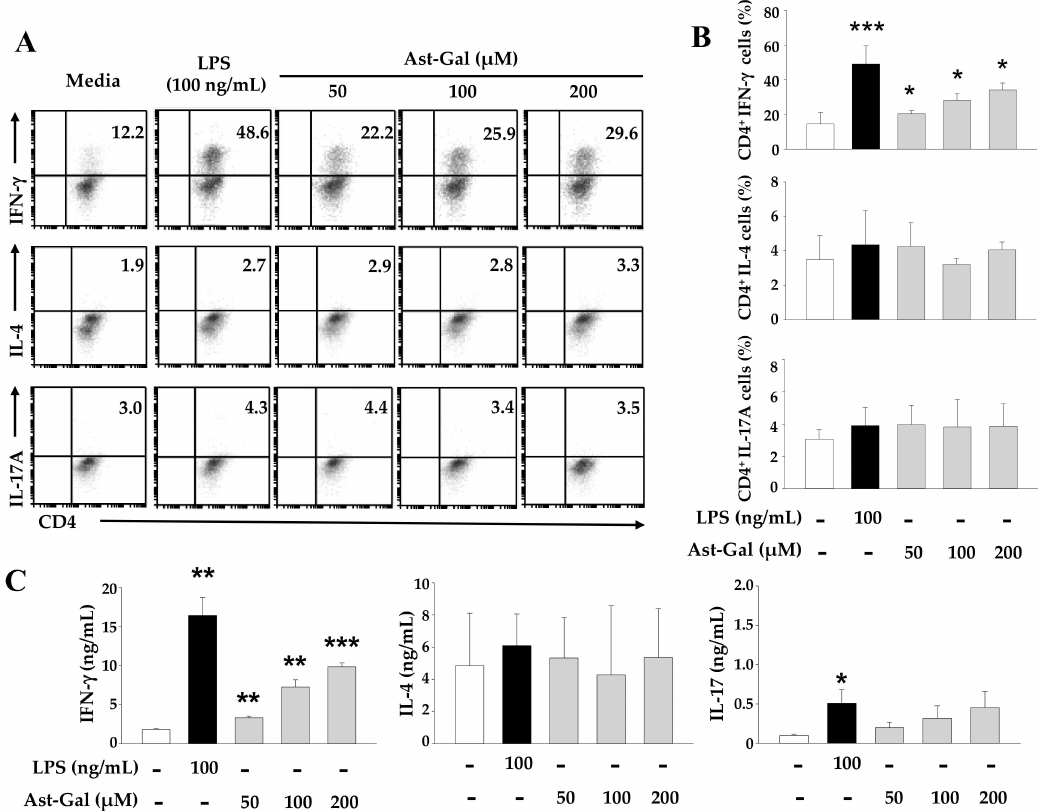
Figure 3. Ast-Gal-stimulated DCs increase IFN- γ production in CD4 + T cells in vitro. The iDCs (5 × 10 4 cells/well) were pulsed with 10 µ g/mL of OVA for 2 h, and stimulated for 6 h with various concentrations of Ast-Gal, LPS (100 ng/mL), or media alone (untreated control). Next, untreated and treated DCs were harvested and cocultured with CD4 + T cells from OVA-specific OT-II mice at the ratio of 1:10 for 3 days. ( A ) The percentages of IFN- γ -, IL-4-, and IL-17-expressing T cell population were determined by flow cytometric analysis. The results shown are representative of three independent experiments. ( B ) The results from ( A ) are summarized as mean ± SD ( n = 3). * p < 0.05, ** p < 0.01, *** p < 0.001 compared with media-treated DCs. ( C ) The production levels of IFN- γ , IL-4, and IL-17 were detected by a sandwich ELISA. The data are expressed as mean ± SD from three experiments which were conducted in triplicate. * p < 0.05, ** p < 0.01, *** p < 0.001 compared with media-treated